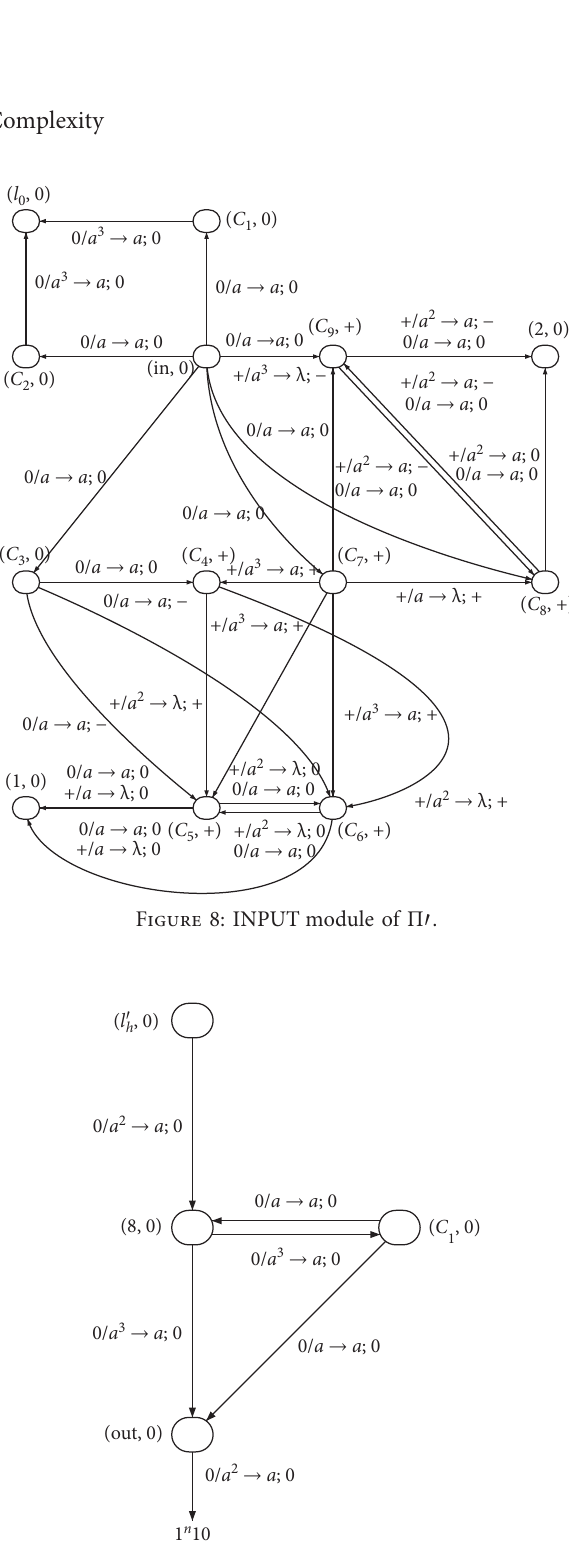
Figure 9: OUTPUT module of Π